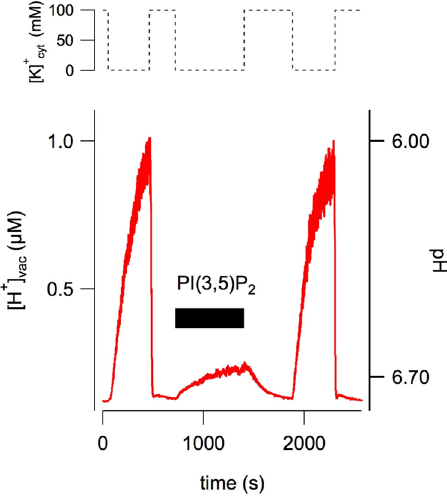
Figure 3: The phosphoinositide PI ( 3,5 ) P 2 inhibited NHX activity.